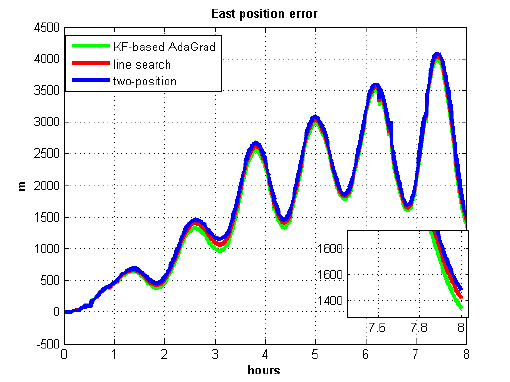
Figure 25. East position error in test 3.